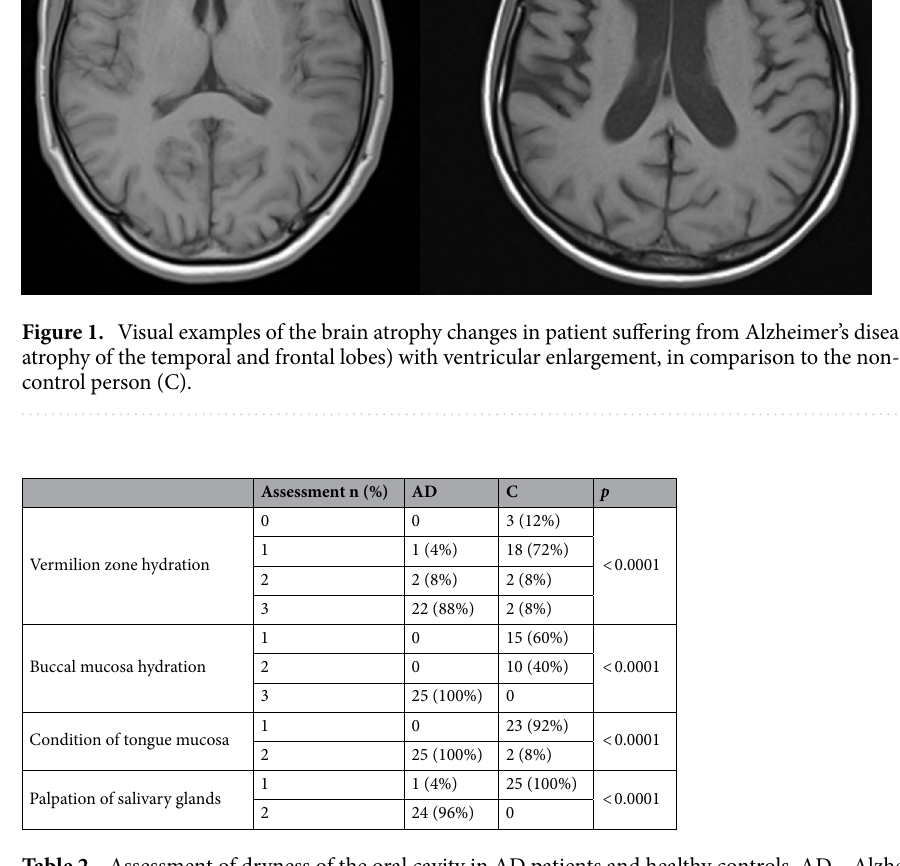
Table 2. Assessment of dryness of the oral cavity in AD patients and healthy controls. AD—Alzheimer’s disease; C—control